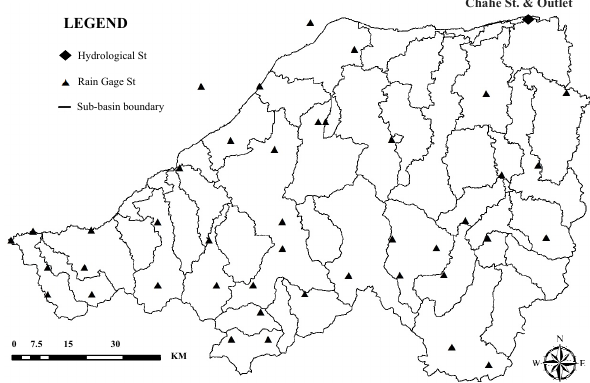
Figure 2. Sub-basins and rain gauge stations in the Xiaoqing catch-